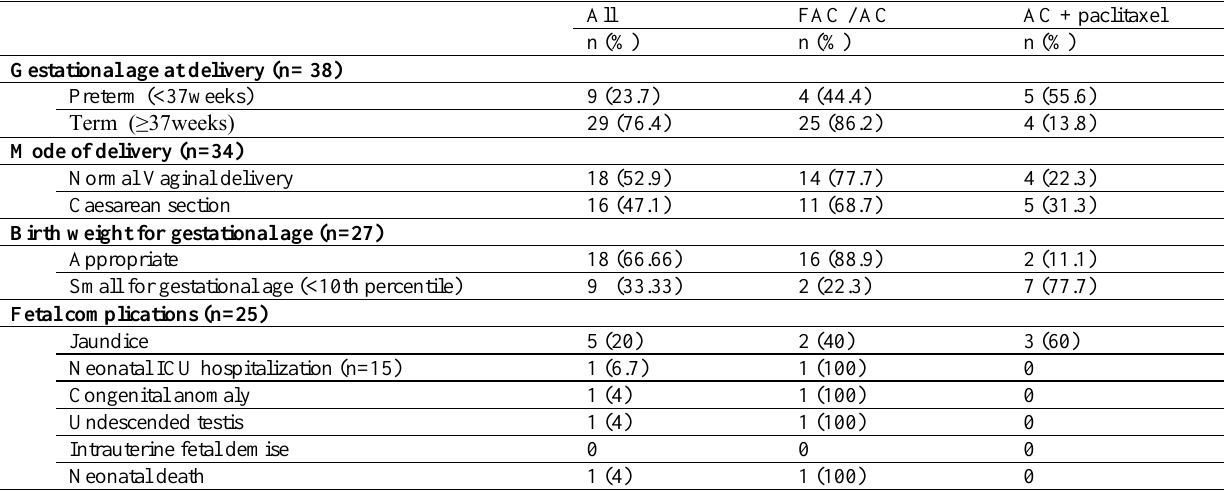
Table 2: Neonatal outcome of children exposed in utero to systemic anti-cancer treatment for breast